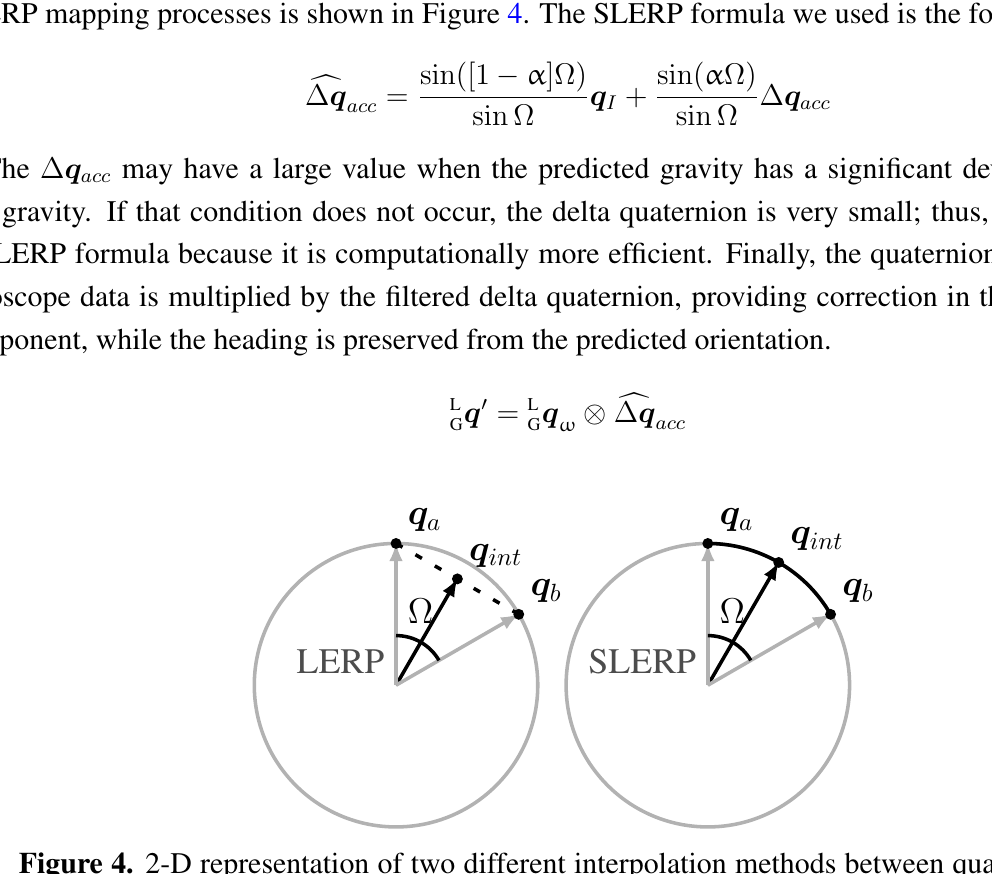
Figure 4. 2-D representation of two different interpolation methods between quaternion q a and q resulting in quaternion q . On the left is represented the linear interpolation (LERP), b int whereas on the right the spherical linear interpolation (SLERP) showing the correct